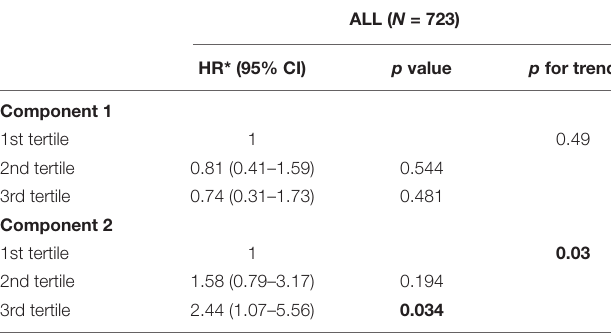
TABLE 3 | Cox proportional hazard model for the primary composite endpoint in the ISAACC